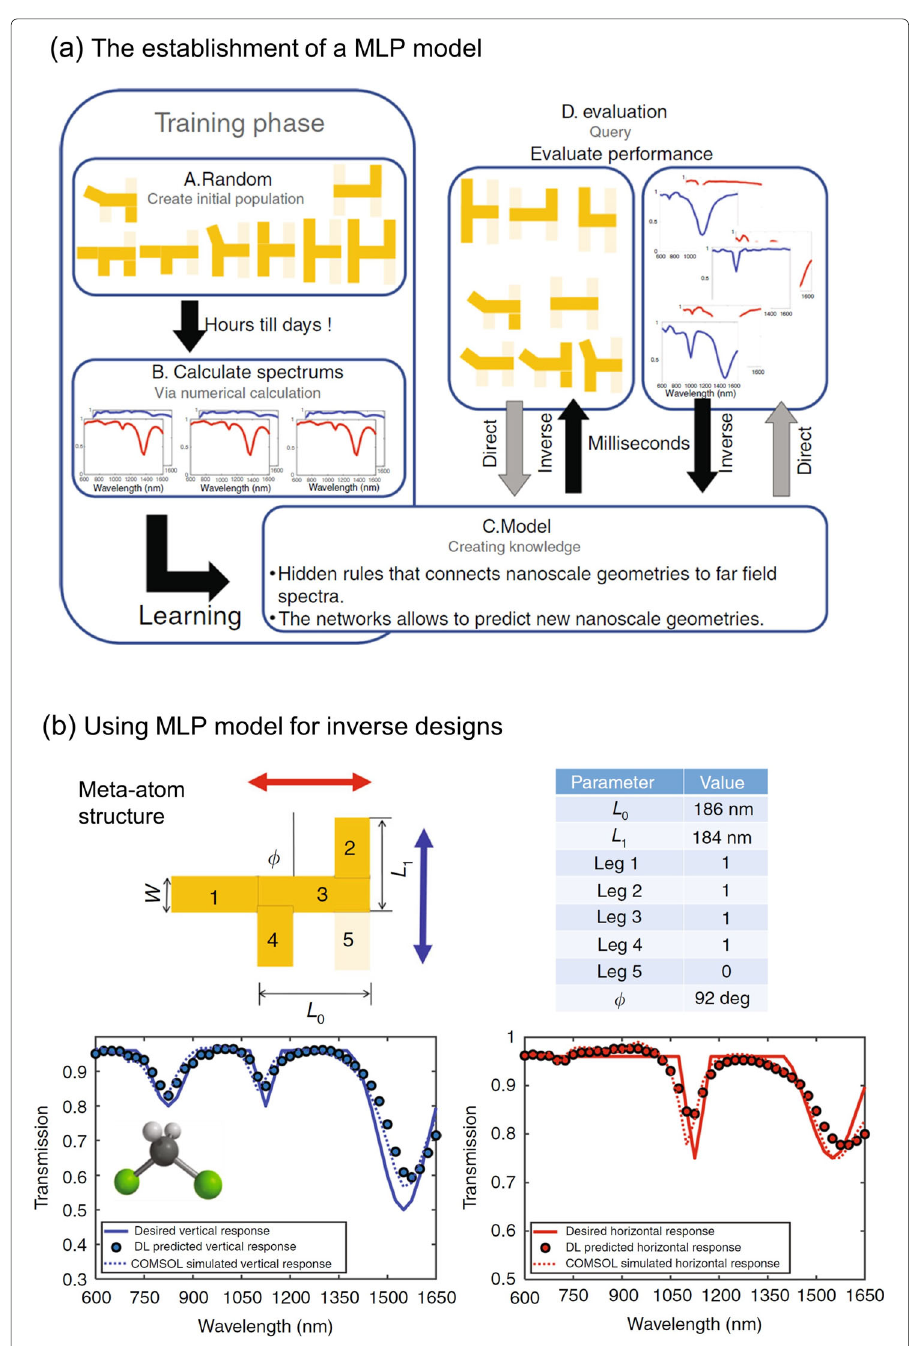
Fig. 5 A mutual directional MLP (a type of DNN) model based upon H-shaped gold meta-atoms. (a) The establishment procedures. The alphabet labels (i.e., A to D) reveal the four phases of constructions, from creation of initial population, spectral computations, model training, to performance evaluations. (b) An inversely drafted meta-atom to fit on-demand sensing usage. The targeted organic molecule dichloromethane, requiring varied spectral polarization responses (e.g., blue for vertical polarization and red for horizontal direction), is depicted in the inside graph on the left spectra. Top: the meta-atom structure with a detailed table of all relative parameters. Bottom: spectral distributions by vertical and horizontal polarized incident light. In each set of transmissions, the spectra exhibit the excellent lineshapes agreement among demanded response (solid lines), DL predictions (dots), and numerical simulations (dashed lines). Figures reproduced with permission: (a) and (b) Ref. [11], Copyright 2018 Nature Publishing